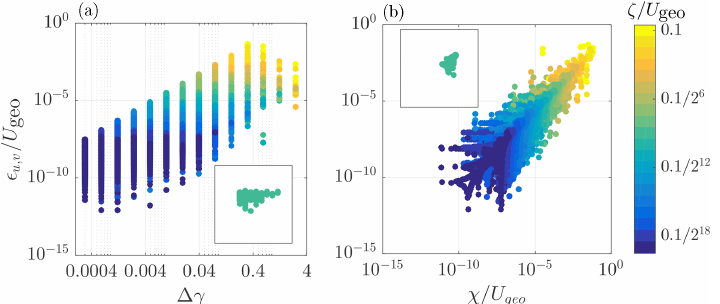
Figure 2. The locally evaluated error in the numerical solutions for u and v at t = t end , based on the analytical solution ( (cid:15) u,v , see Eq. 23) for 20 runs using the adaptive-grid approach with different refinement criteria (see colour bar). Panel (a) shows that the diagnosed errors for each run plotted against the mesh-element size used ( (cid:49) ). The inset (using the same axis scales) shows the results for a single run. Panel (b) shows the correlation between the wavelet-based estimated error ( χ ) and the corresponding diagnosed error in the numerically obtained solution ( (cid:15) ). The inset (using the same axis scales) shows the results for a single run and reveals a relatively small spread in both (cid:15) and χ values compared to the equidistant-grid results presented in Fig.